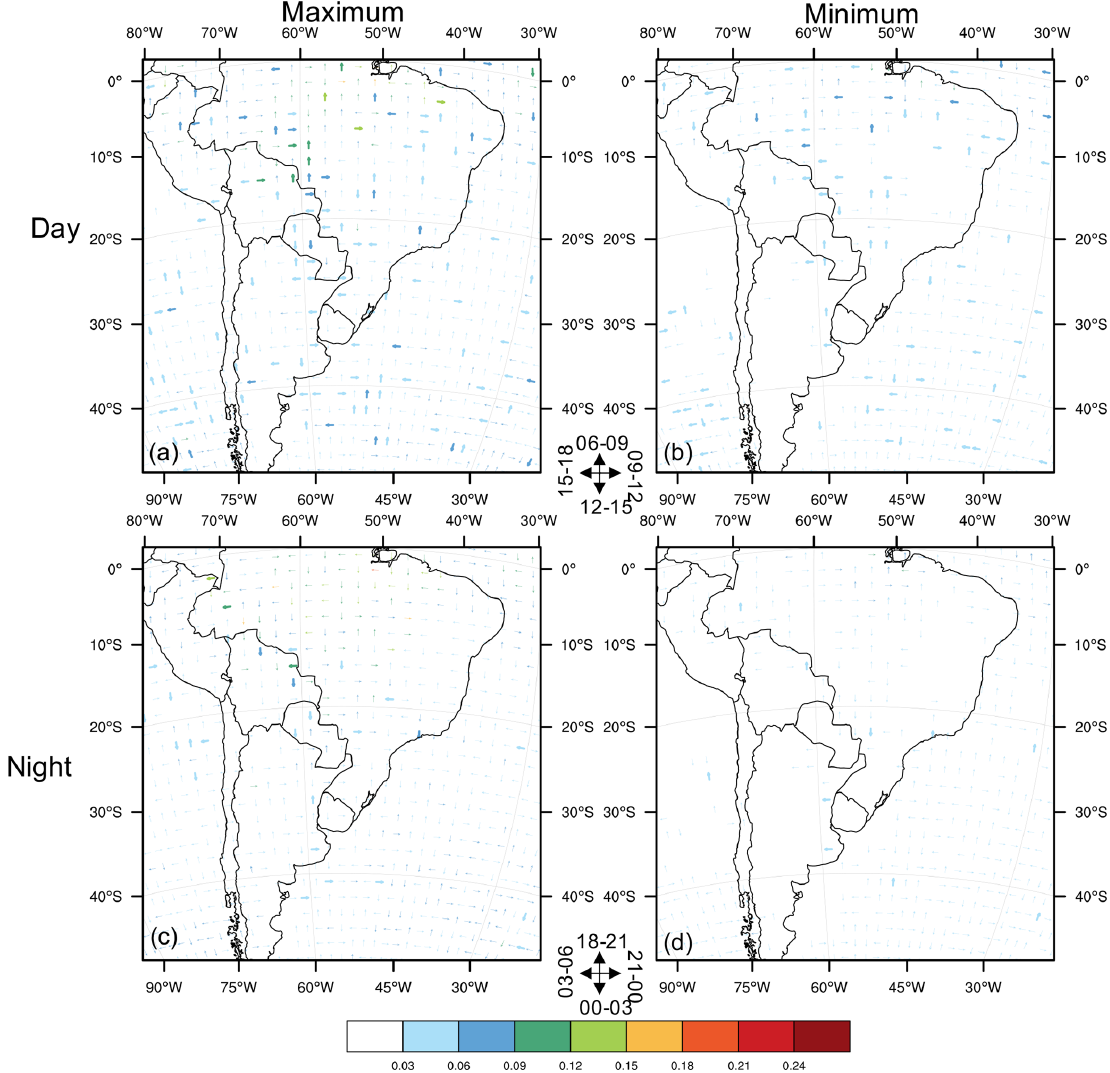
Figure 7. Diurnal (a, c) maximum and (b, d) minimum DAOD across South America during the (a, b) daytime and (c, d) nighttime periods. Figure elements are the same as in Fig.